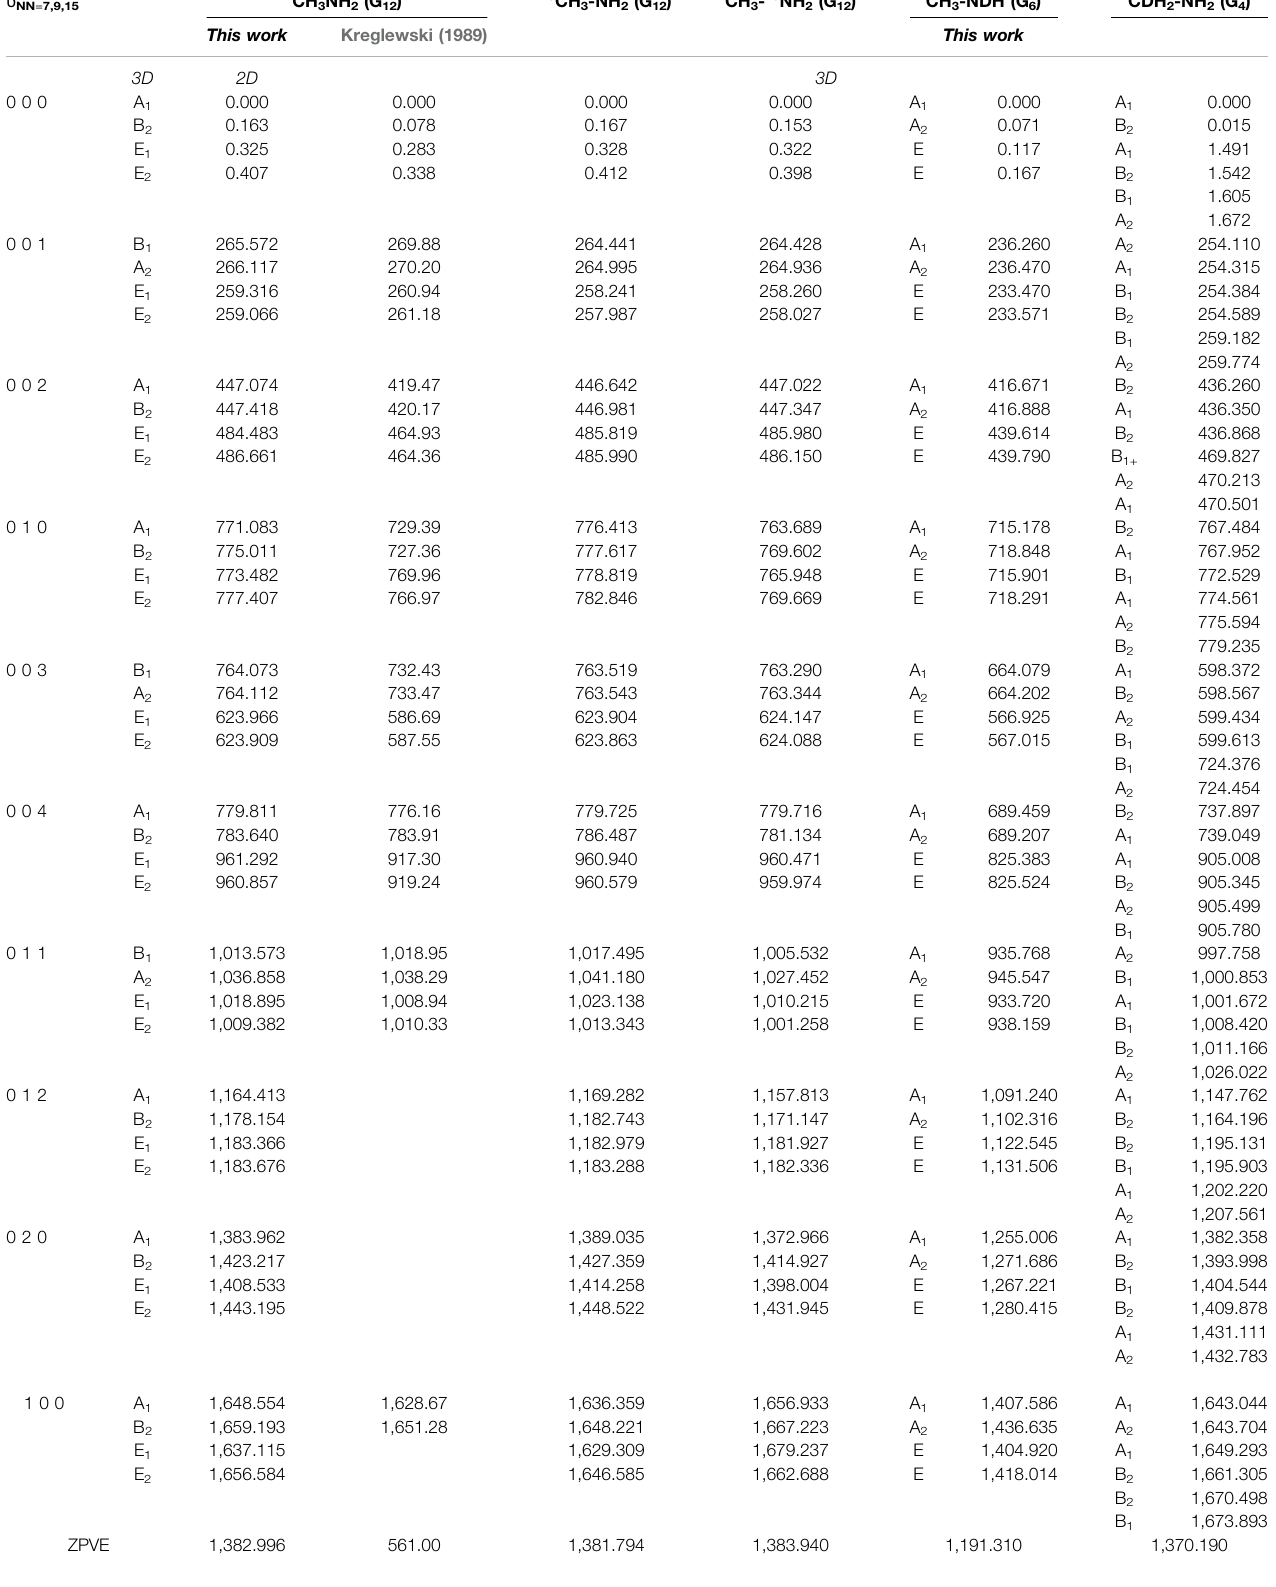
TABLE 6 | CCSD(T)-F12 energy levels corresponding to the large amplitude vibration and to the HNH bending mode (in cm − 1 ). For the main isotopologue, the energies compared with previous data obtained using a two-dimensional model. ʋ NN =